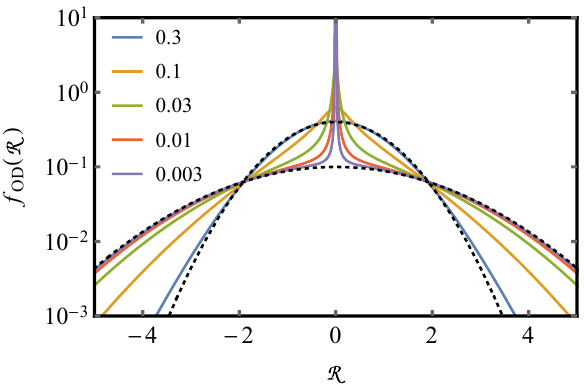
( R ) of the off-diagonal matrix elements of operators on the Figure 11: Distribution f OD (cid:112) χ bath : Eq. (107) is plotted for different values of J (cid:63) from the intermediate regime (values in legend, inset). The dotted lines show the limiting cases of weak coupling, ( R ) → 1 ( R | 0,2 ) + 1 δ ( R ) , and strong coupling f ( R ) → f ( R | 0,1 ) f where f OD N OD N 2 2 ( R | µ , σ 2 ) is the normal (where f N